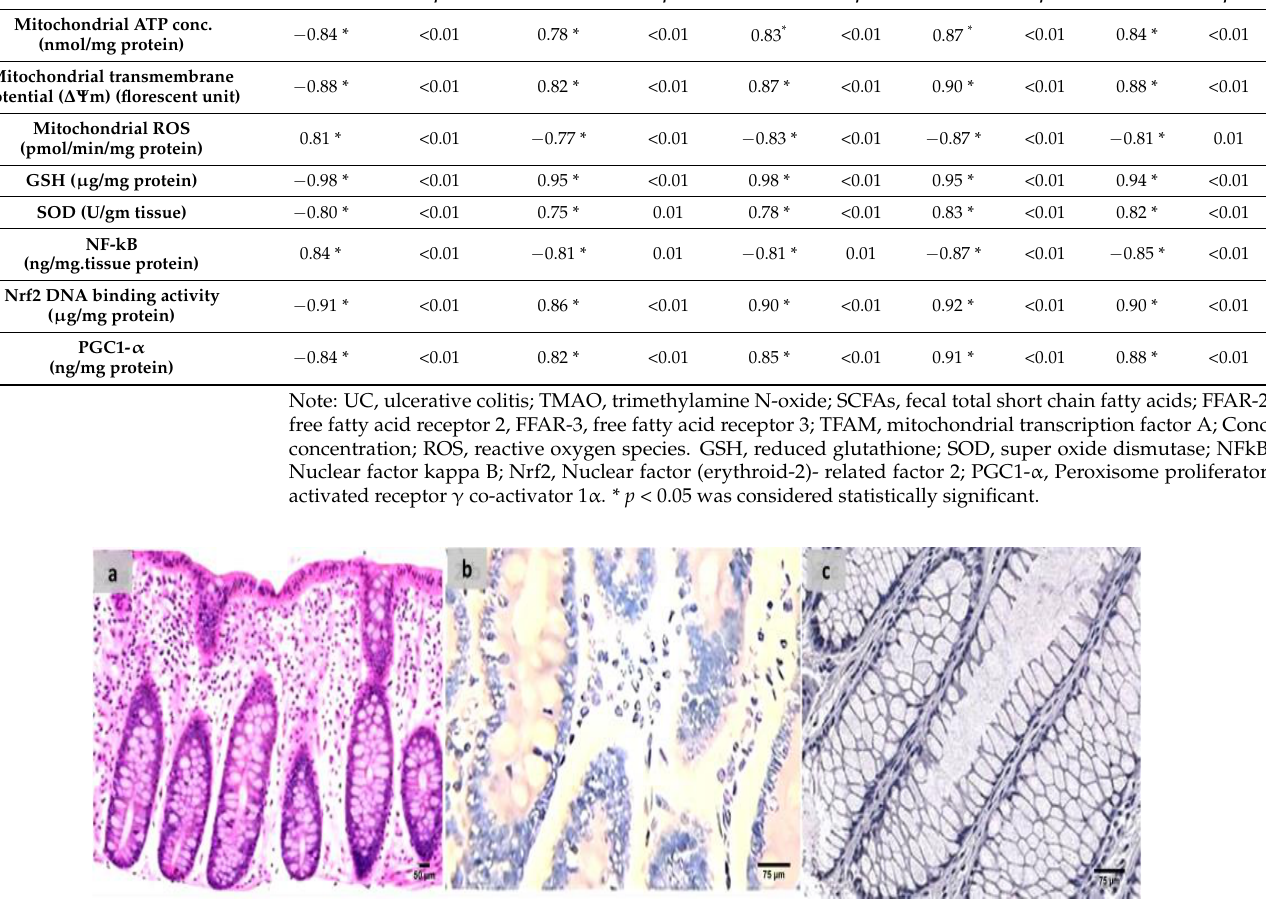
Table 5. Correlation between TMAO, SCFAs, FFAR2, FFAR3, TFAM, and measured variables in the UC group. TMAO SCFAs FFAR-2 FFAR-3 TFAM